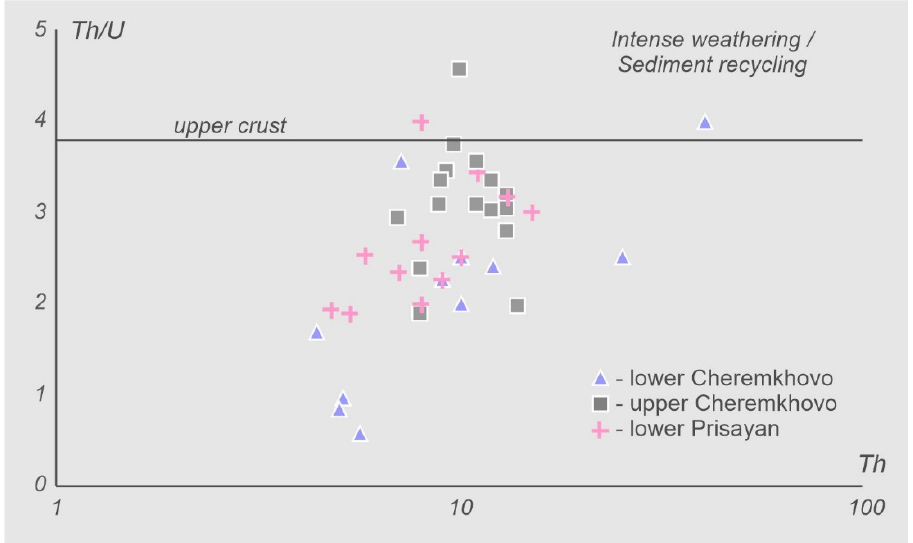
Figure 10. Th versus Th/U plot (after [39] ).